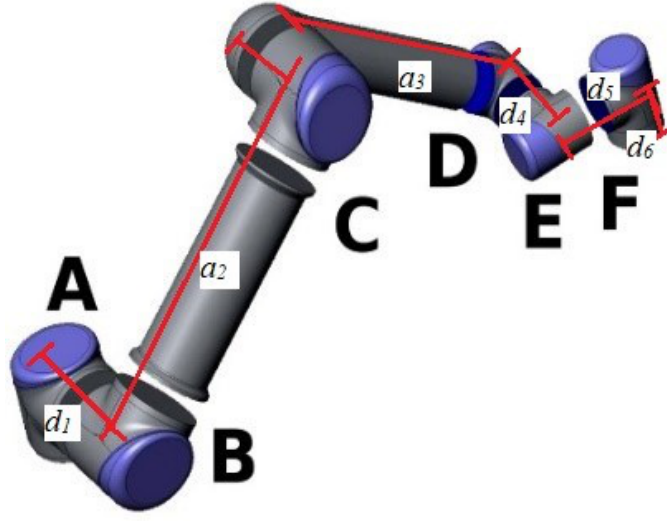
Fig. 1 UR5 robotic arm with 6 degrees of